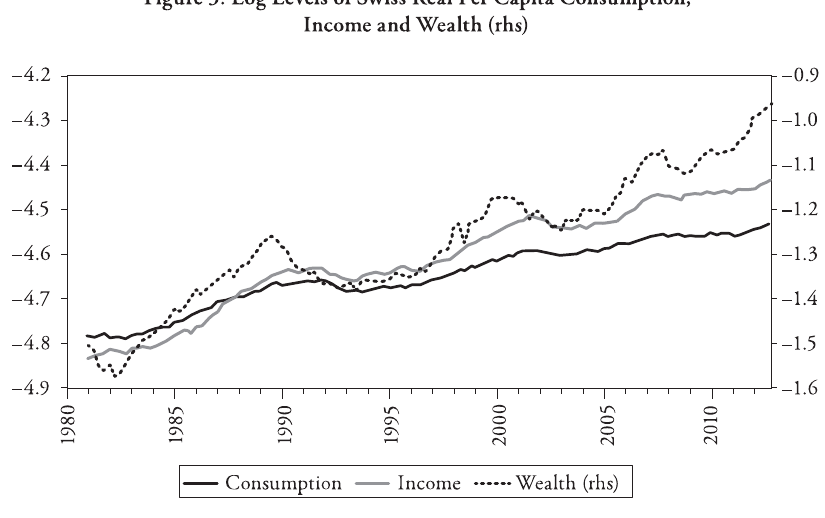
Figure 3: Log Levels of Swiss Real Per Capita Consumption, Income and Wealth (rhs)